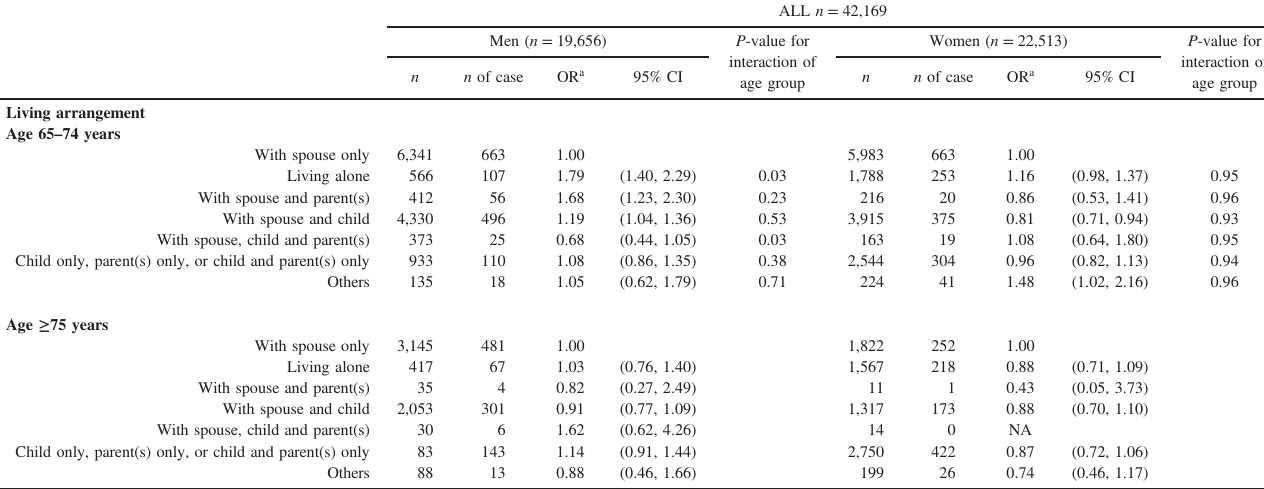
Table 3. Gender-speci fi c adjusted odds ratios of living arrangement for depressive